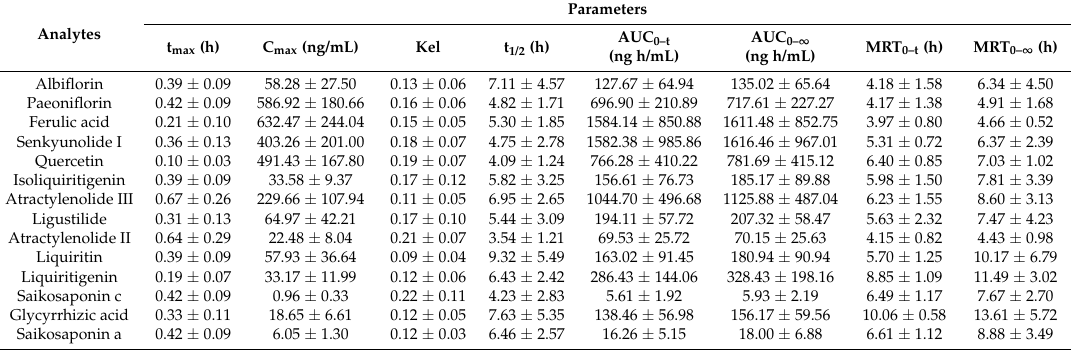
Figure 2. Plasma concentration-time profiles of 14 analytes in rats after oral administration of XYP (4 g/kg) (mean ± SD, n = 6). Table 5. The main pharmacokinetic parameters after oral administration of XYP with 4 g/kg. Data are presented as mean ± SD ( n =